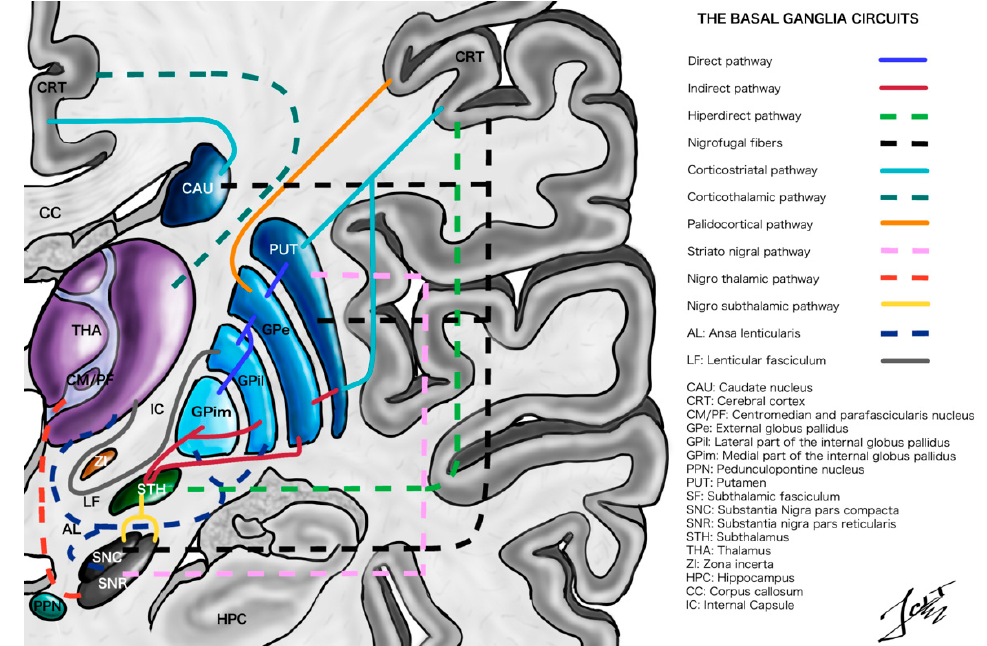
Figure 1. This figure shows a coronal section of the basal ganglia circuit with emphasis on its complex connections. Illustrated by J. Lizana.